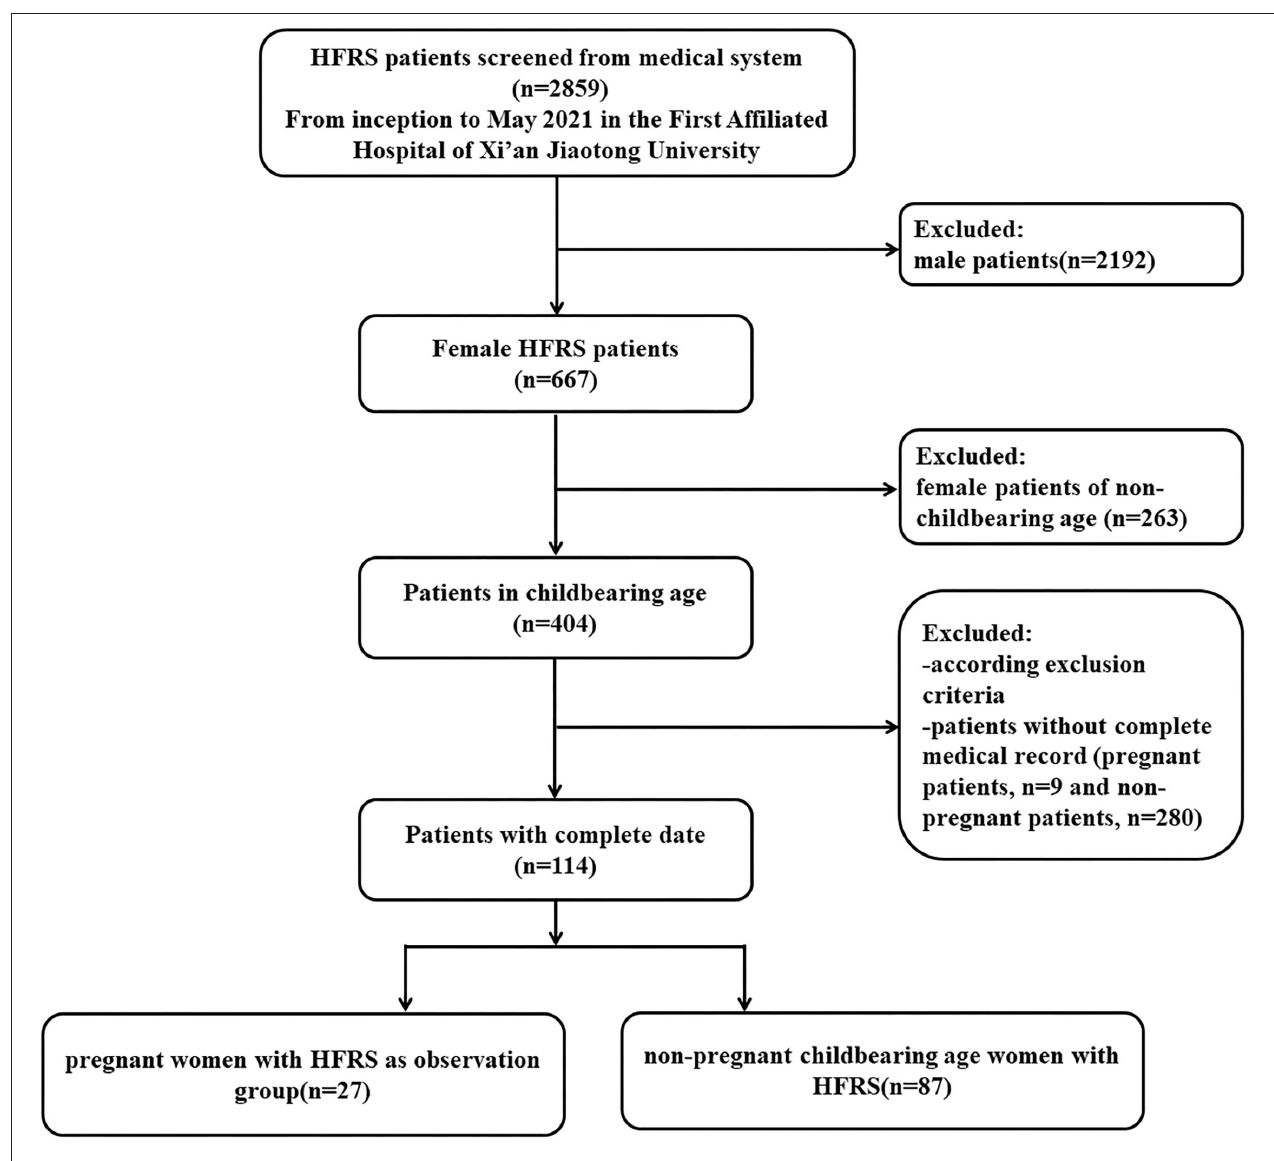
FIGURE 1 | Flowchart of patient